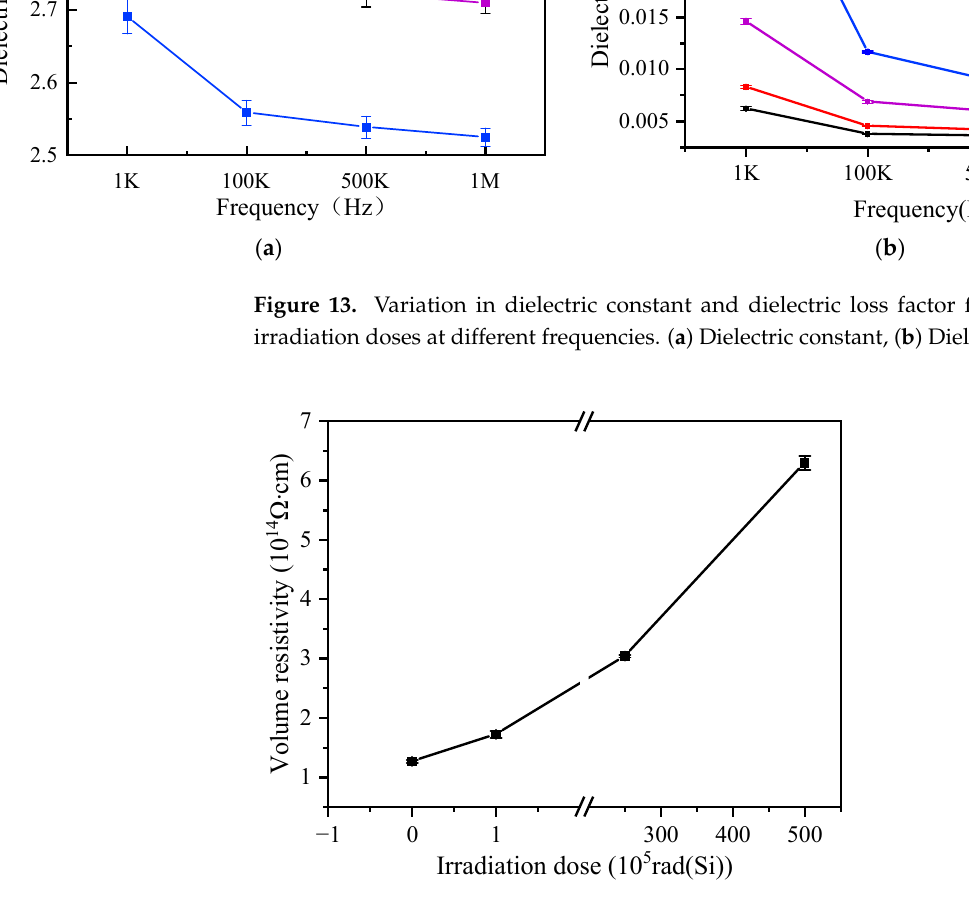
Figure 13. Variation in dielectric constant and dielectric loss factor for samples with different irra- diation doses at different frequencies. ( a ) Dielectric constant, ( b ) Dielectric loss factor.